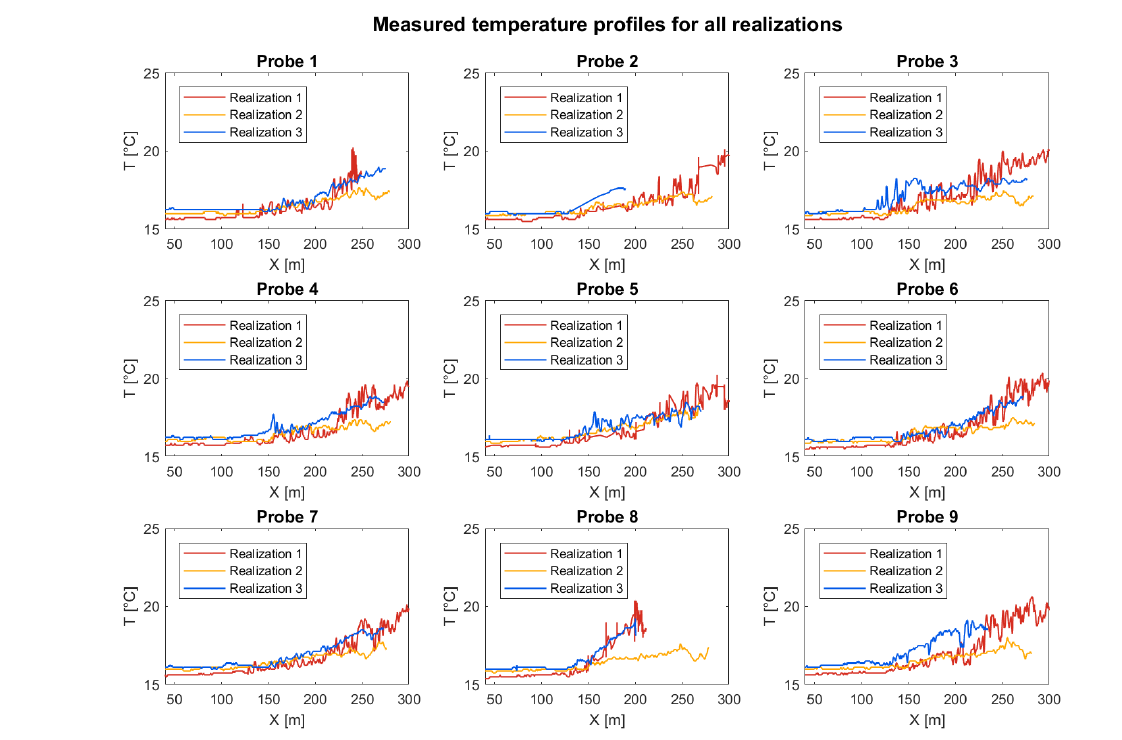
Figure 16. Measured